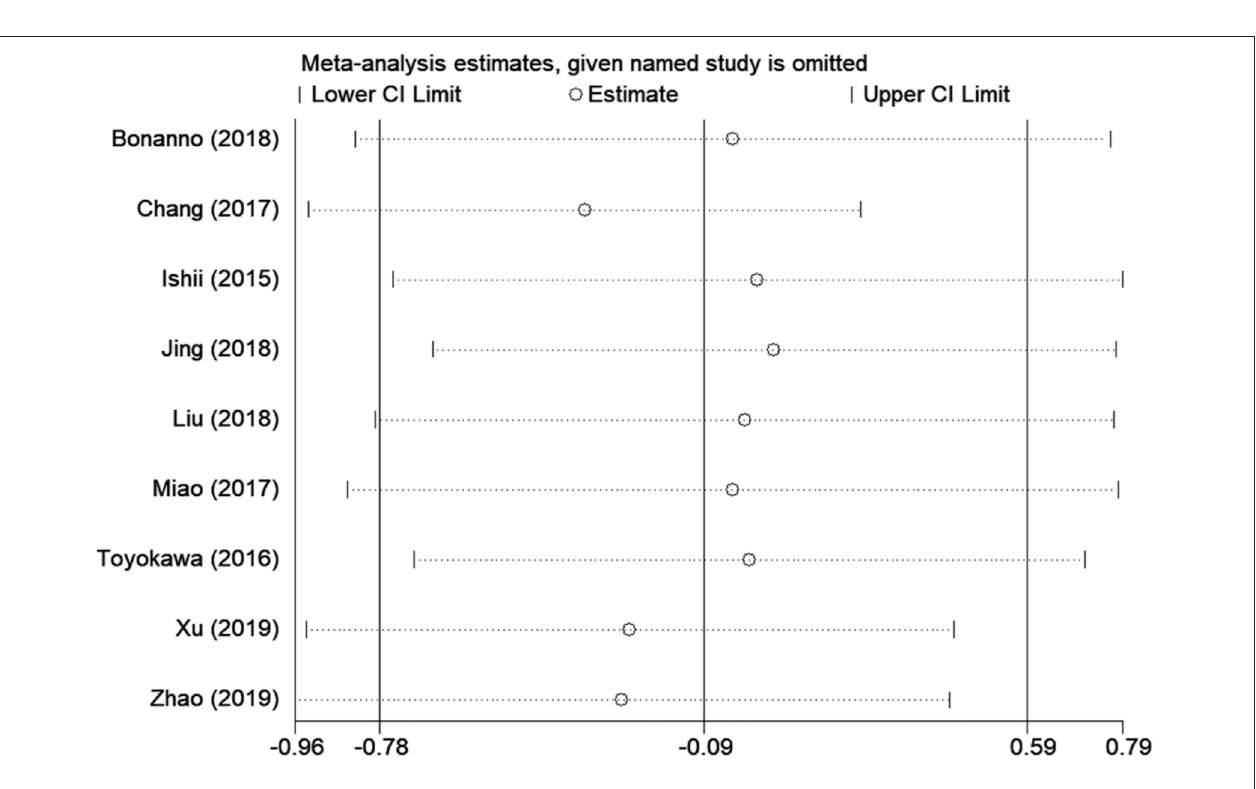
FIGURE 3 | Sensitivity analysis of PD-L1 and OS.